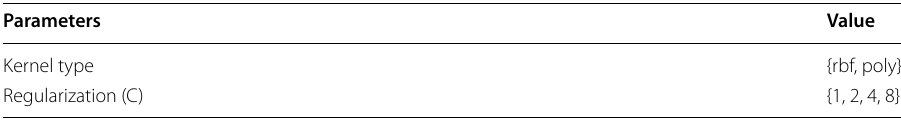
Table 5 Parameter space of SVM